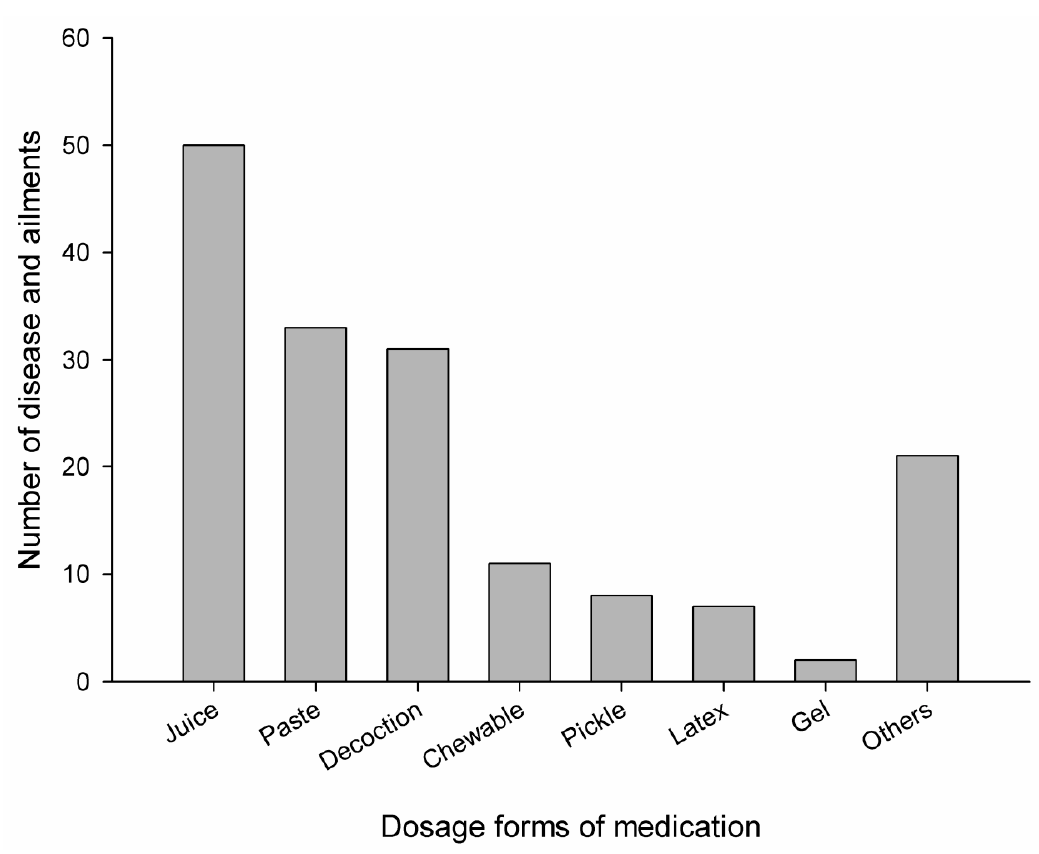
Figure 3. Dosage forms of medication in the treatment of different diseases and ailments by the local people.